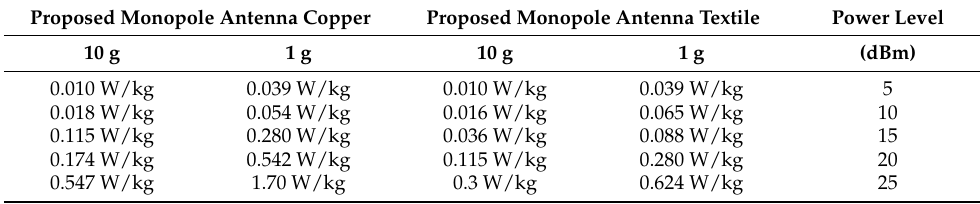
Table 3. Comparison of measured SAR levels for the proposed monopole antenna at 5.2 GHz. Proposed Monopole Antenna